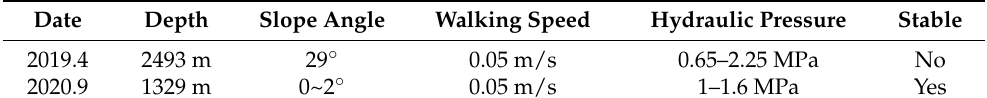
Table 8. The parameters of the two sea trials.